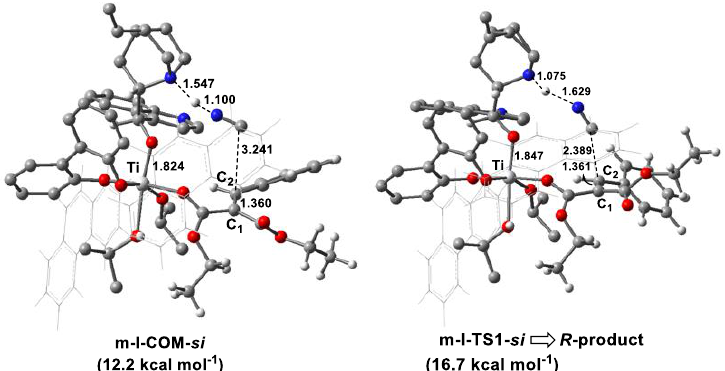
Figure 5. Optimized structures of the monodentate Ti(IV)-complex (m-I-COM- si ) and TS (m-I-TS1- si ) in the C-C bond construction step in the catalytic cyanation reaction of olefin along the si -face attack pathway and their relative Gibbs free energies. The intermolecular distance is in Angstroms (Å). The color definitions of atoms are red = oxygen, blue = nitrogen, gray = carbon and white = hydrogen.